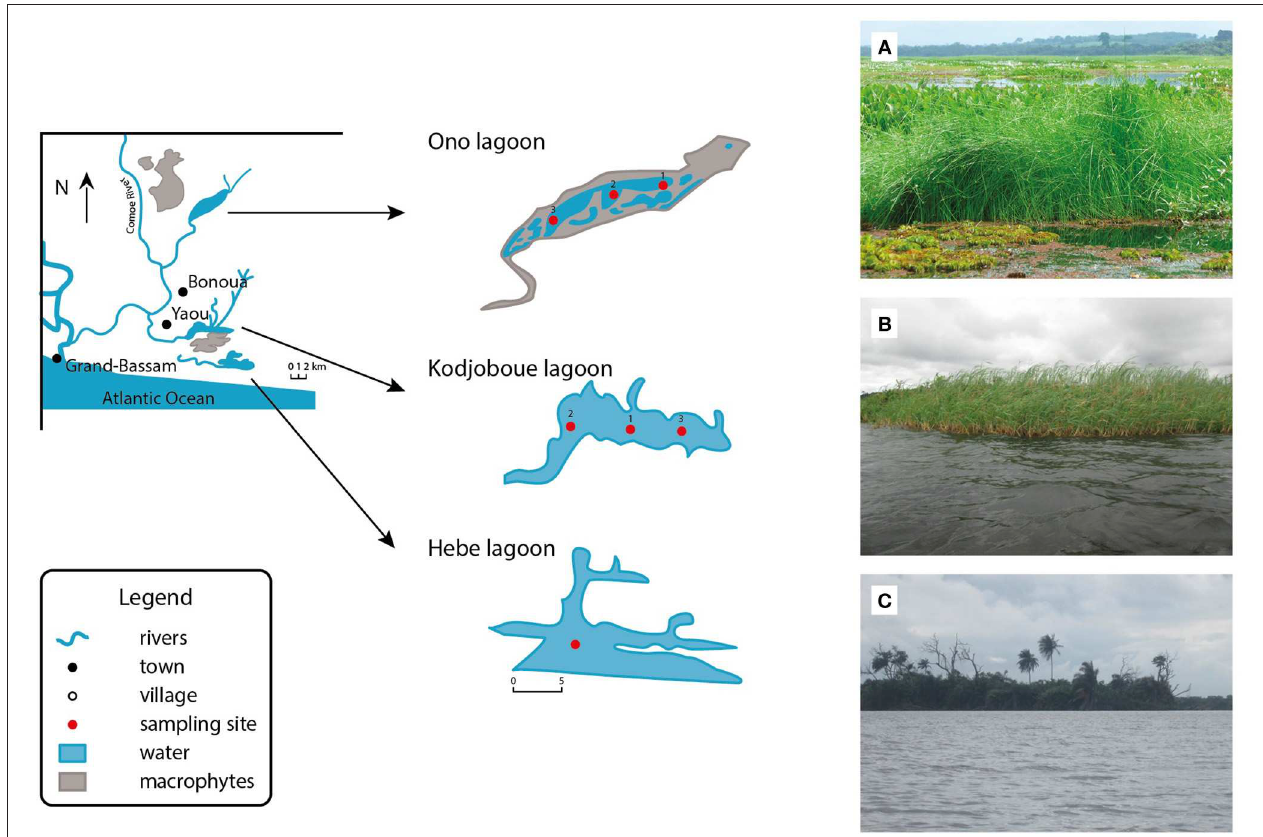
FIGURE 1 | Map showing the location of the different lagoons with a photo impression of their macrophyte cover ( A , Ono; B , Kodjoboue; C , Hebe).